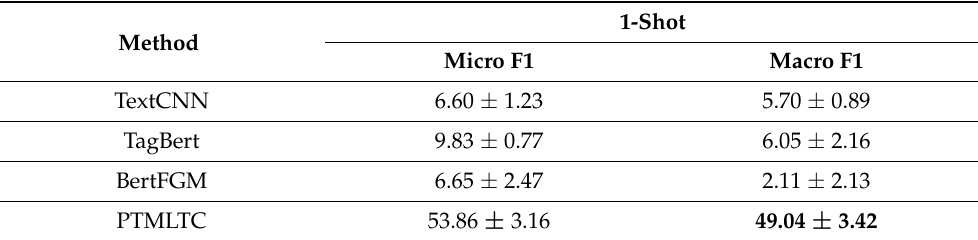
Table 2. Results of 1-shot on our dataset. Metrics marked in bold contain the highest metrics for the dataset.